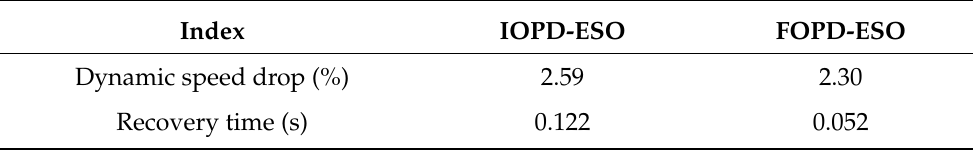
Table 4. Load disturbance response performances of IOPD-ESO and